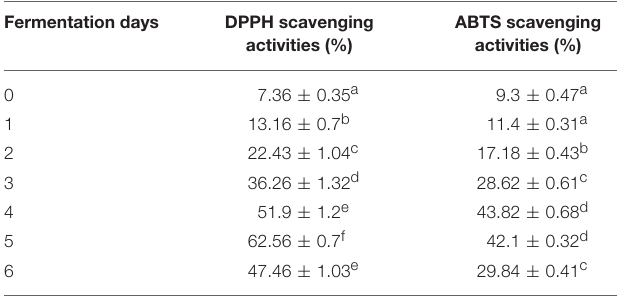
TABLE 7 | Radical scavenging activities of fermented rice as measured by DPPH and ABTS assays. Fermentation days